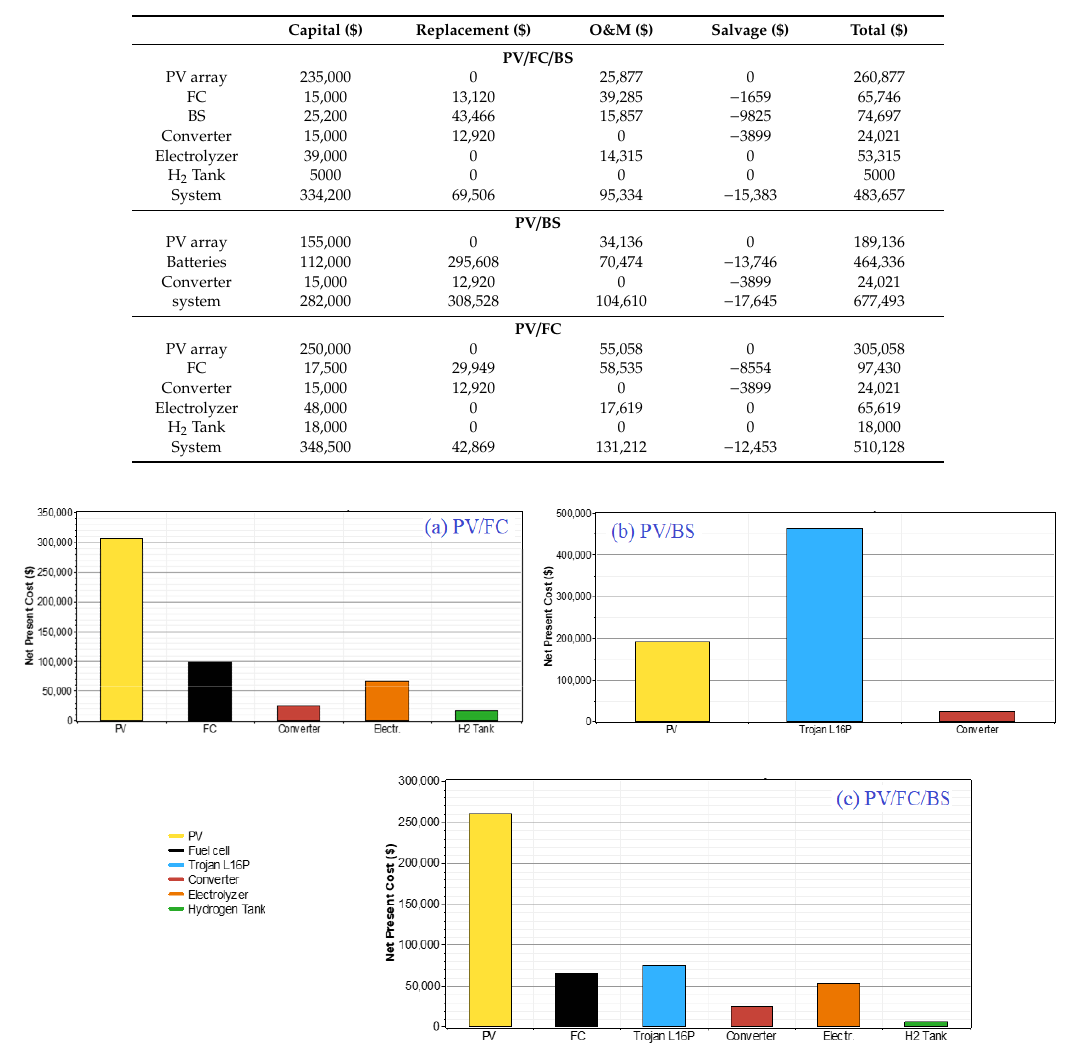
Table 4. Related costs of di ff erent components for each considered system.